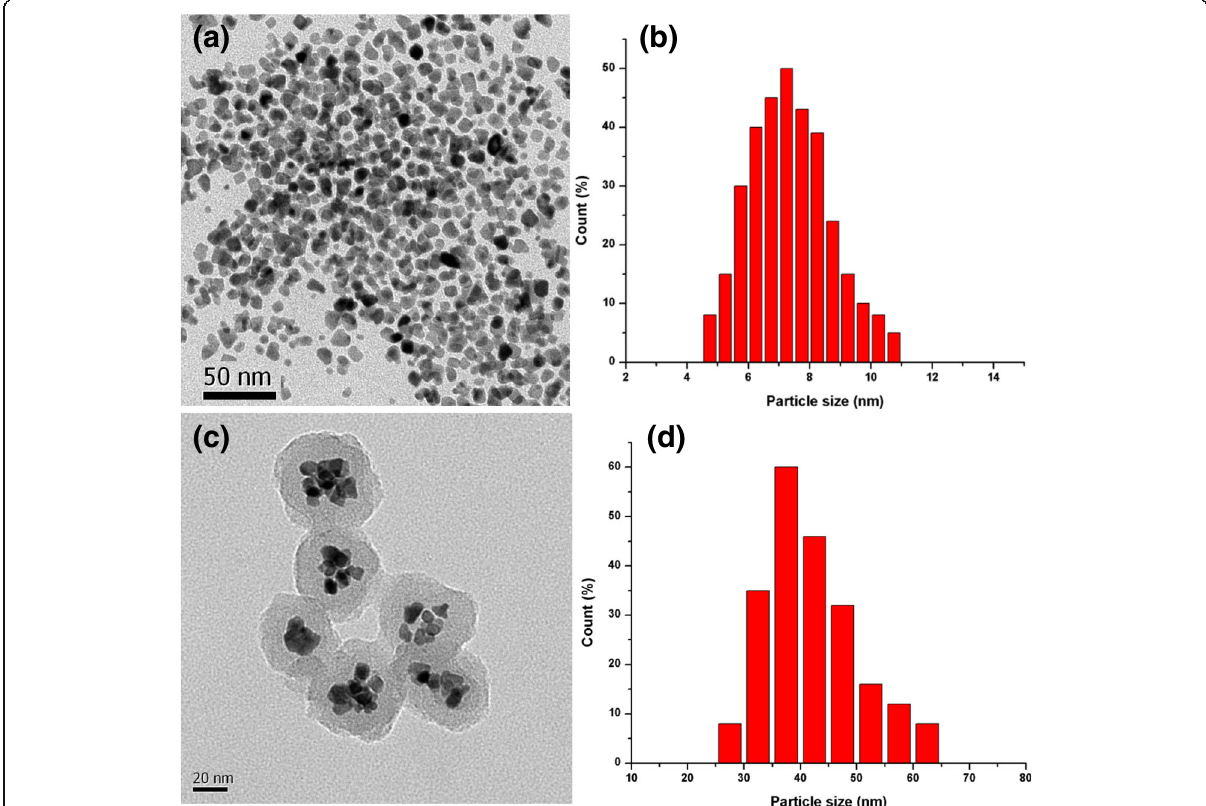
Fig. 1 a TEM and b corresponding size distributions of pure FePt NPs. c TEM and d corresponding size distributions of FePt@PPy NPs